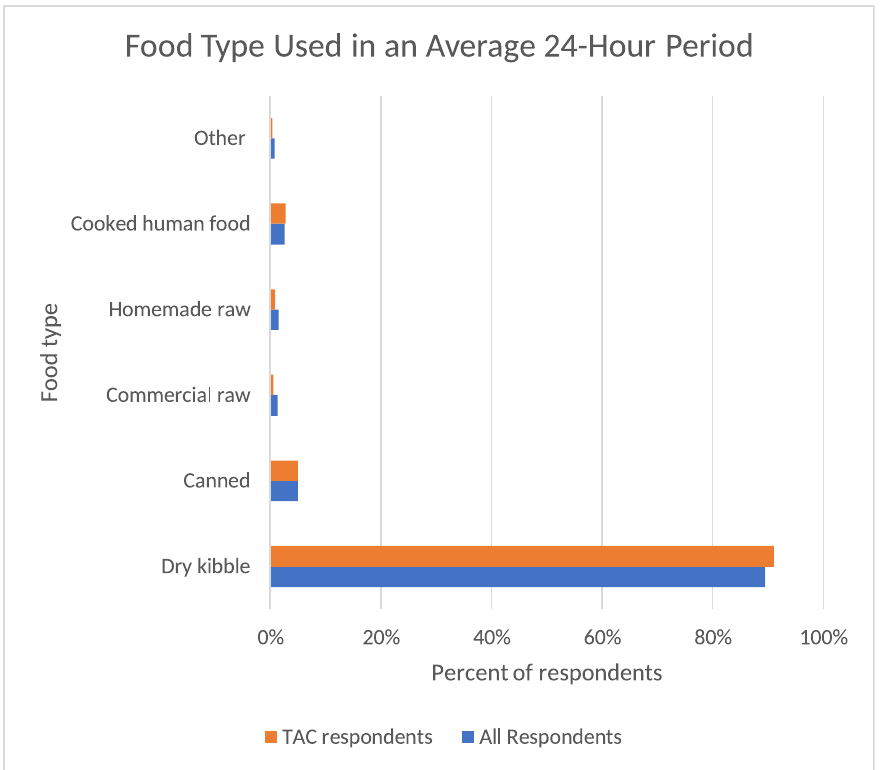
Fig 1. Food type used in average 24-h period. Comparison of food type among all survey respondents and respondents of those participating in the APC assessment.